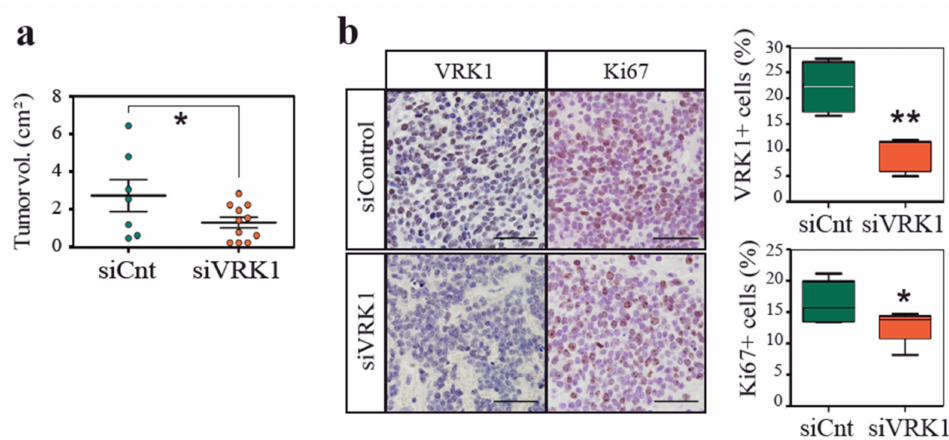
Figure 4. VRK1 downregulation impairs neuroblastoma tumorigenesis in a xenograft model. ( a ) Volume of tumors in mice collected after flank injection with SK-N-SH cells 24 h after transfection with either VRK1 or control siRNA; ( b ) Immunohistochemical staining showing VRK1 and Ki67 protein expression in representative tumors from each condition. Percentage of positive cells are shown. Scale bars: 60 µ